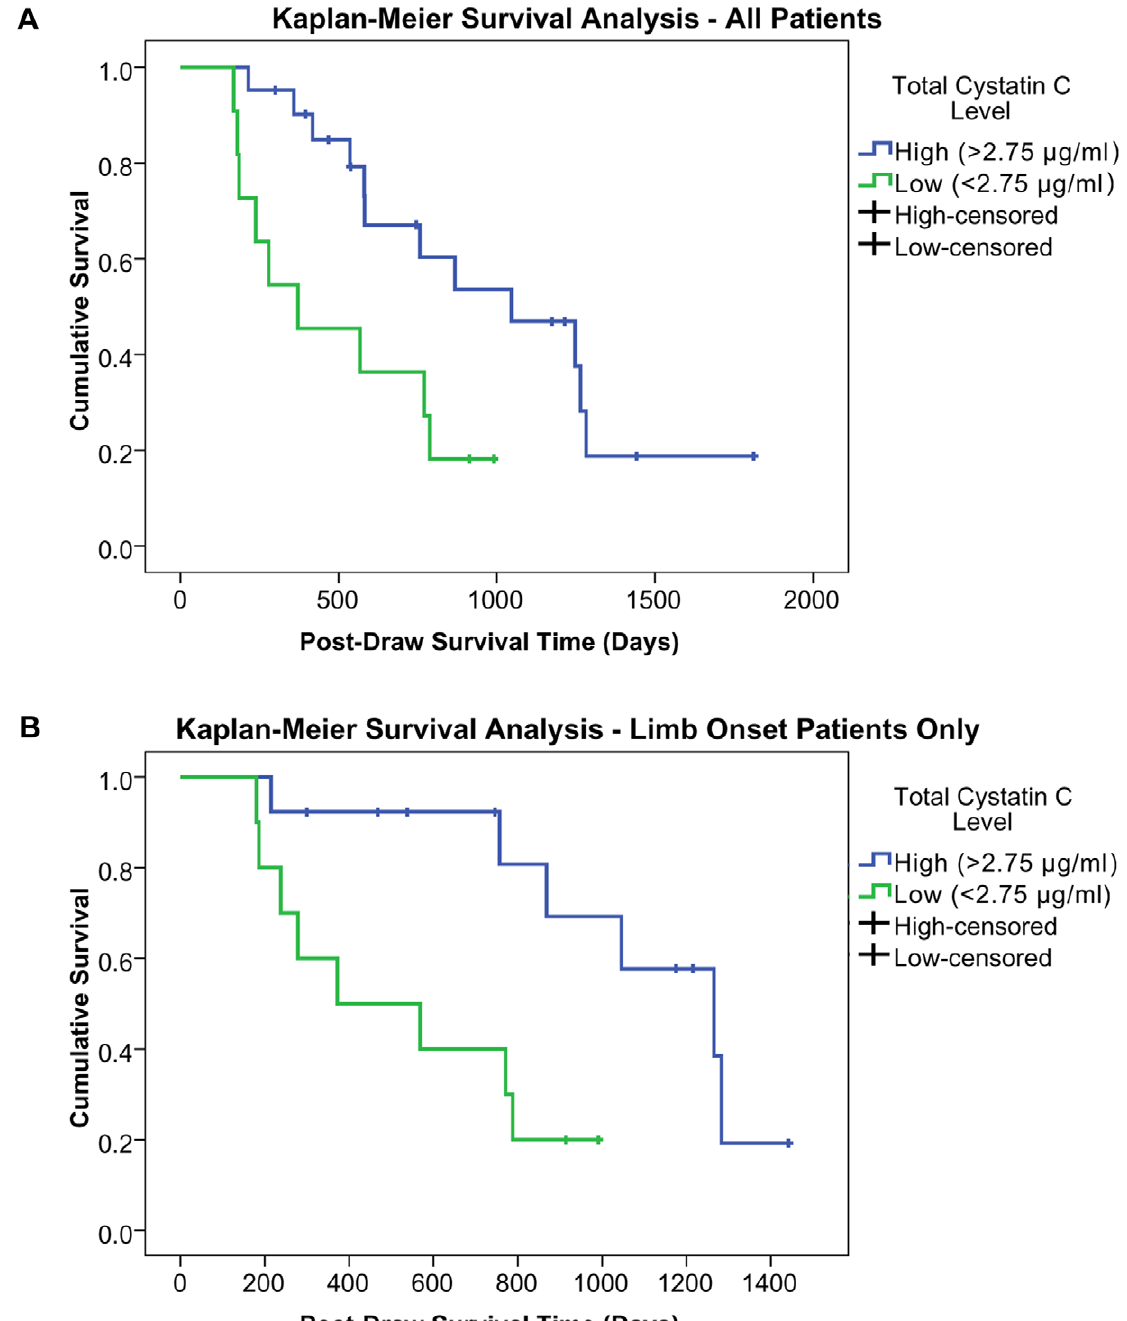
Figure 2. Kaplan-Meier survival curves. For all ALS patients ( A ), survival was significantly longer ( p , 0.014) in patients with high cystatin C levels (n=21) than in patients with low cystatin C levels (n=11). For patients with limb onset ALS ( B ), the same trend was observed, but with a larger survival difference ( p , 0.010) between patients with high (n=13) and low (n=10) cystatin C levels.